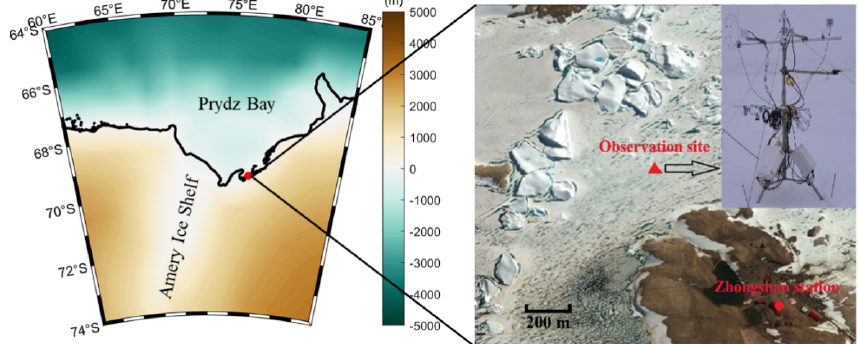
Figure 1. Location of landfast sea ice surface measurements near Zhongshan Station. The solid triangle denotes the observation site, and the solid circle marks Zhongshan Station. The color on the left represents the terrain.